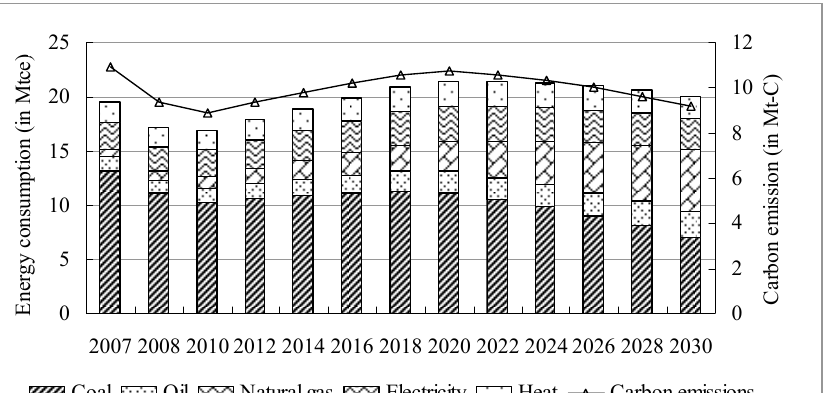
Figure 4. Energy consumption of the industrial sector under the IS,